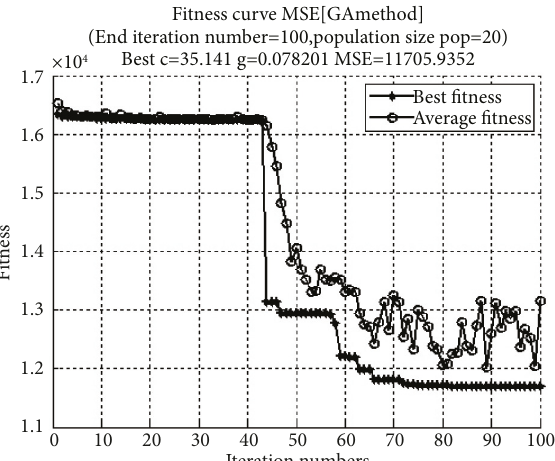
Figure 8: GA-SVM optimization process of CO data.